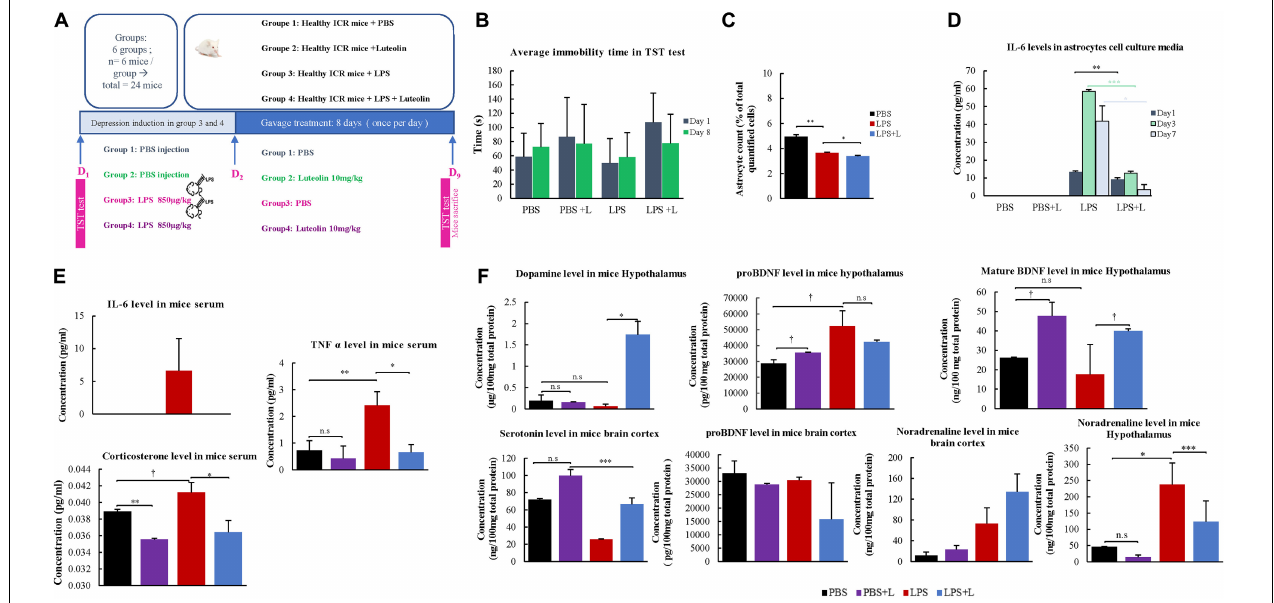
FIGURE 3 | Behavioral and physiological effects of Luteolin treatment on LPS depression induced mice. (A) Experimental design. (B) Effect of the oral administration of luteolin (10 mg/kg) on LPS depression induced mice (LPS + L) immobility times in tail suspension test compared to the control (PBS), the EPS group untreated with luteolin (LPS) and to control group treated with luteolin (PBS + L) at day 1 and at day 8. Results are expressed in mean of immobility time ± SD. Paired t -test was applied to compare results of the same group between Day 1 and Day 8, no significant results were obtained, One-way ANOVA test was applied to compare between groups at Day 1 and at Day 8, no significant results were obtained. (C) Effect of luteolin treatment on astrocytes numbers. Results are expressed as mean of astrocytes percentage of three independent experiments ± SD. (D) Effect of luteolin treatment on IL-6 secretion by cultured primary at Day 1, Day 3, and Day 7. Results are expressed as mean concentration of IL-6 secreted in isolated primary astrocytes’ cell culture media of three independent experiments ± SD. (E,F) ELISA assays results. Data are expressed as mean of concentration ± S.D. of three independent experiments. ∗∗∗ p < 0.001, ∗∗ p ≤ 0.01, ∗ p < 0.05, and † p < 0.1, n.s: not significant (ANOVA followed by Dunnett’s post hoc